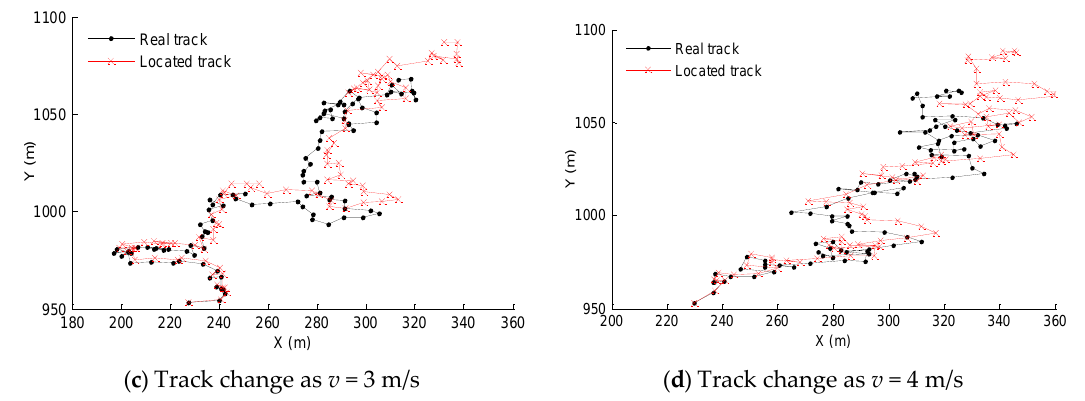
Figure 12. Impacts of nodes’ velocity on localization results.